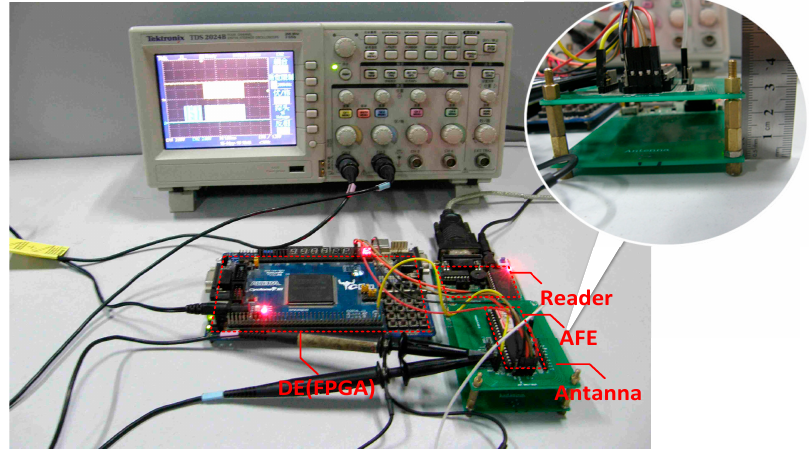
Figure 8. Functional measurement setup based on PCB and the demodulation signal from the